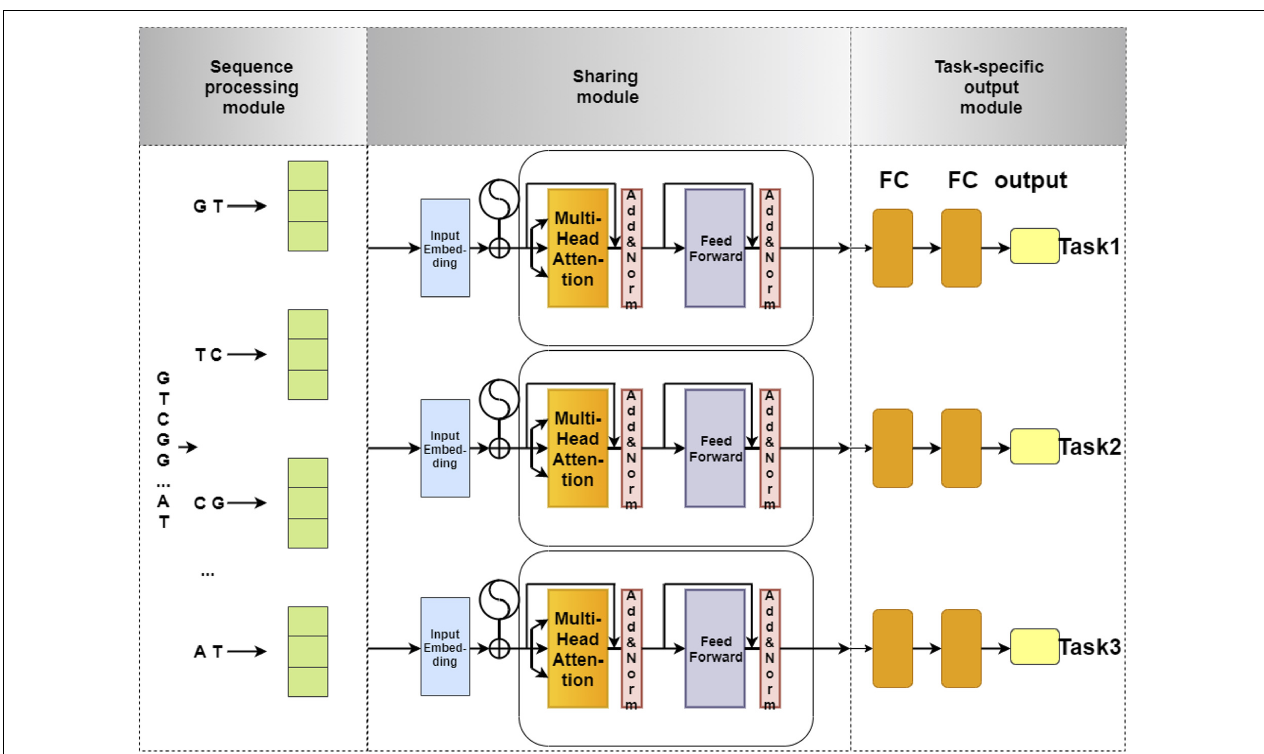
FIGURE 1 | The flowchart of 4mCPred-MTL. The sequence processing module uses 2-gram to split an original DNA sequence into overlapping subsequences and converts them into feature vectors by one-hot encoding. Next, the feature vectors of subsequences are fed into the sharing module, containing a Transformer encoder and a max-pooling layer, to capture the sharing information among different species. Finally, the output of the sharing module is fed into the task-specific output module to predict the 4mC site of a certain